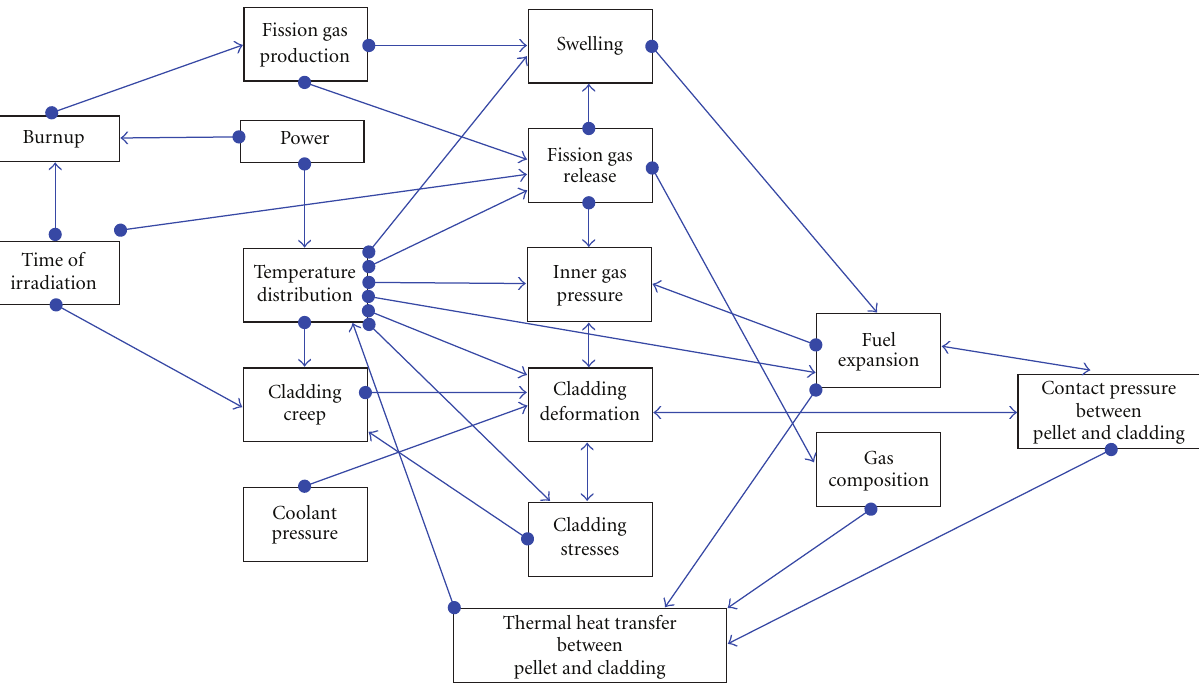
Figure 2: Flux diagram showing the strong interaction existing between di ff erent characteristics included in the simulation of the fuel rod behaviour.